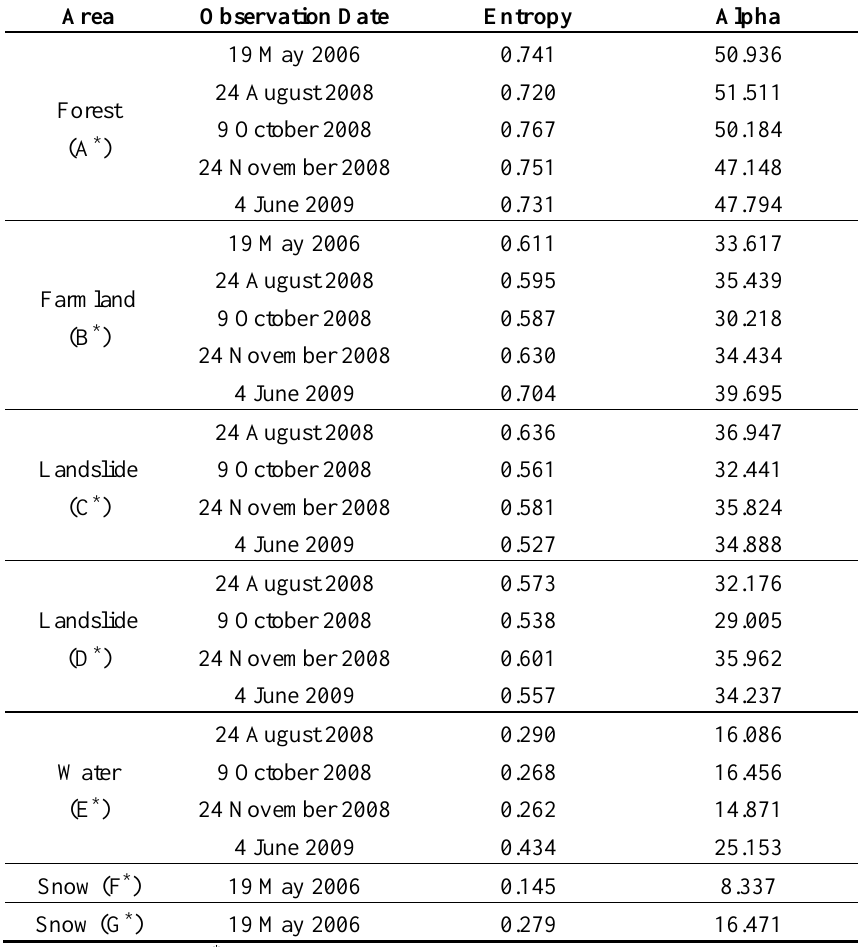
* Letters correspond to areas denoted in Figure